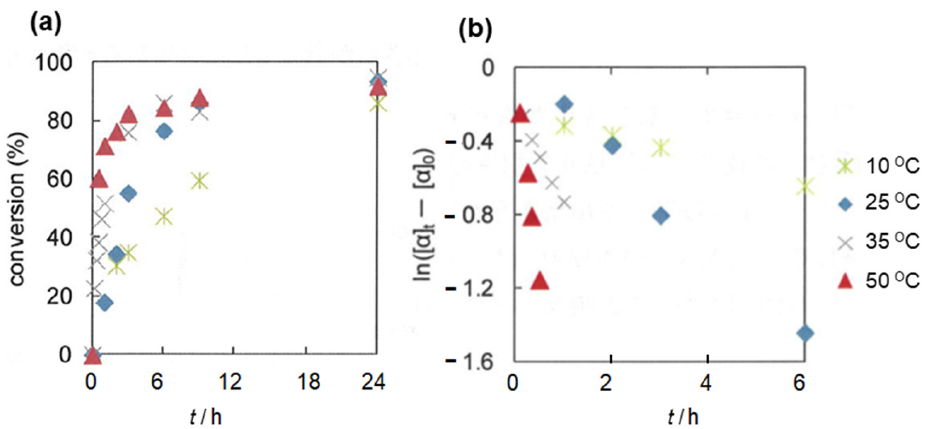
Figure 6. Oligomerization of 1-hexene catalyzed by NiBr 2 ( L1 )–MAO. ( a ) Time conversion of 1-hexene at 25 °C. ( b ) First-order plots of the total reaction.